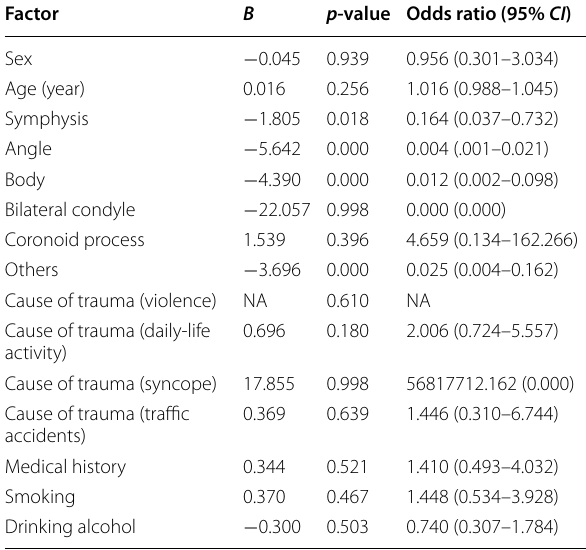
Table 4 Logistic regression analysis of patients with symphysis